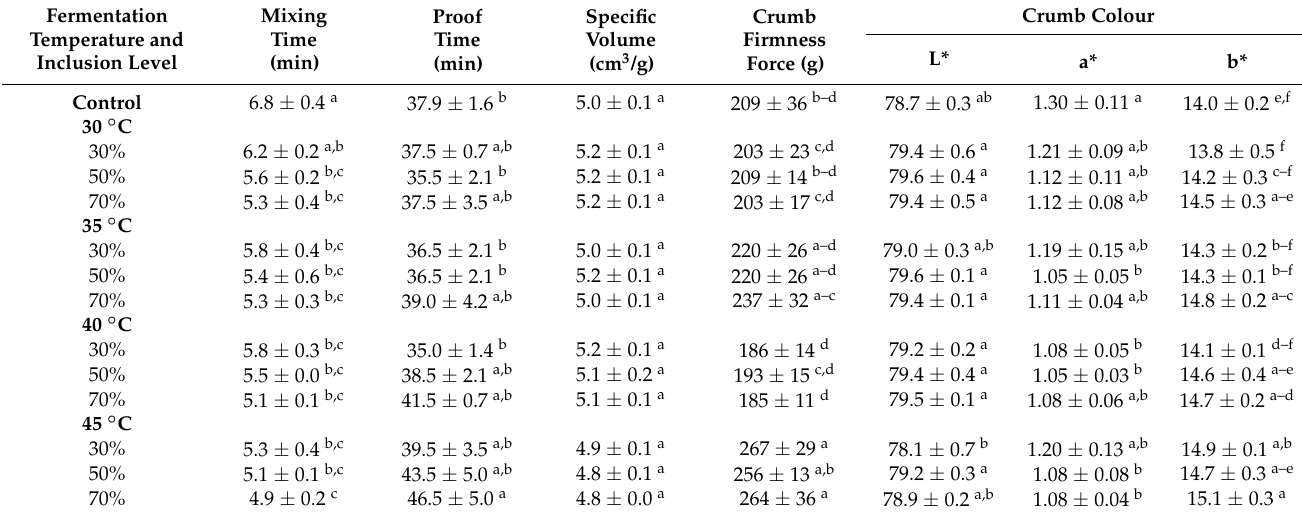
Table 11. Processing parameters, bread specific volume, crumb firmness and colour of the control and breads containing ferment prepared during varying fermentation temperatures 1 .